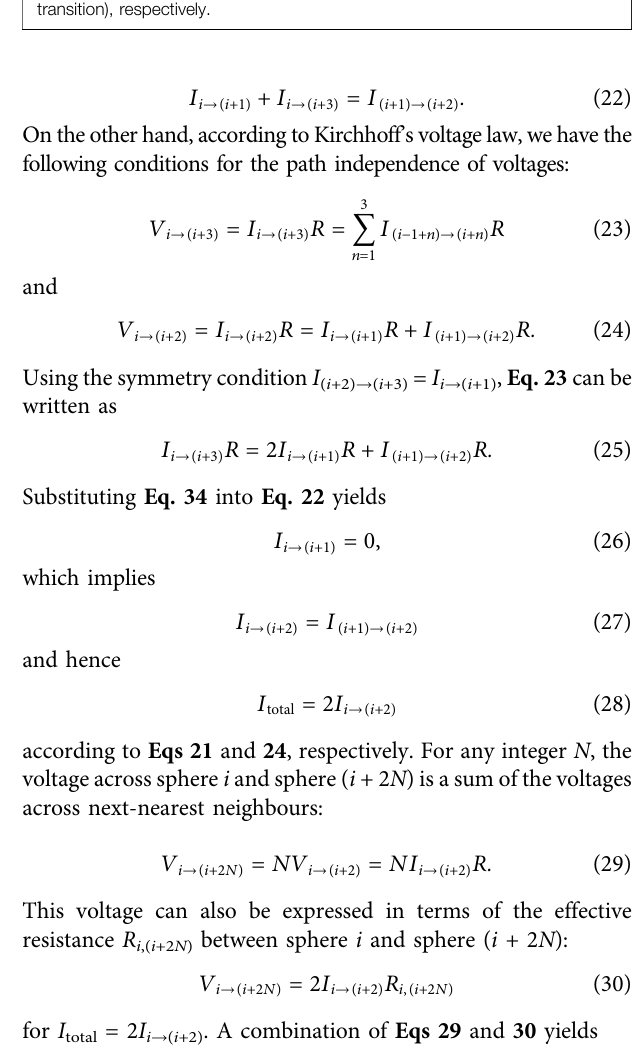
FIGURE 5 | Plot of the rescaled electrical conductivity σ ′ as a function of the cylinder-to-sphere diameter ratio D . The vertical dashed lines indicate a (cid:1)(cid:1) √ discontinuous rise in σ ′ at D (cid:1) 1 + 3 /2 (discontinuous zigzag-to-single-helix transition) and D (cid:1) 2 (discontinuous double-helix-to-double-helix transition),